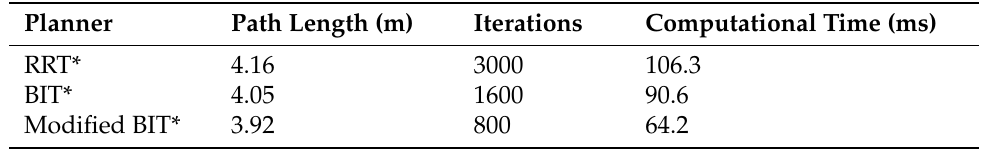
Table 1. The average of ten results of three